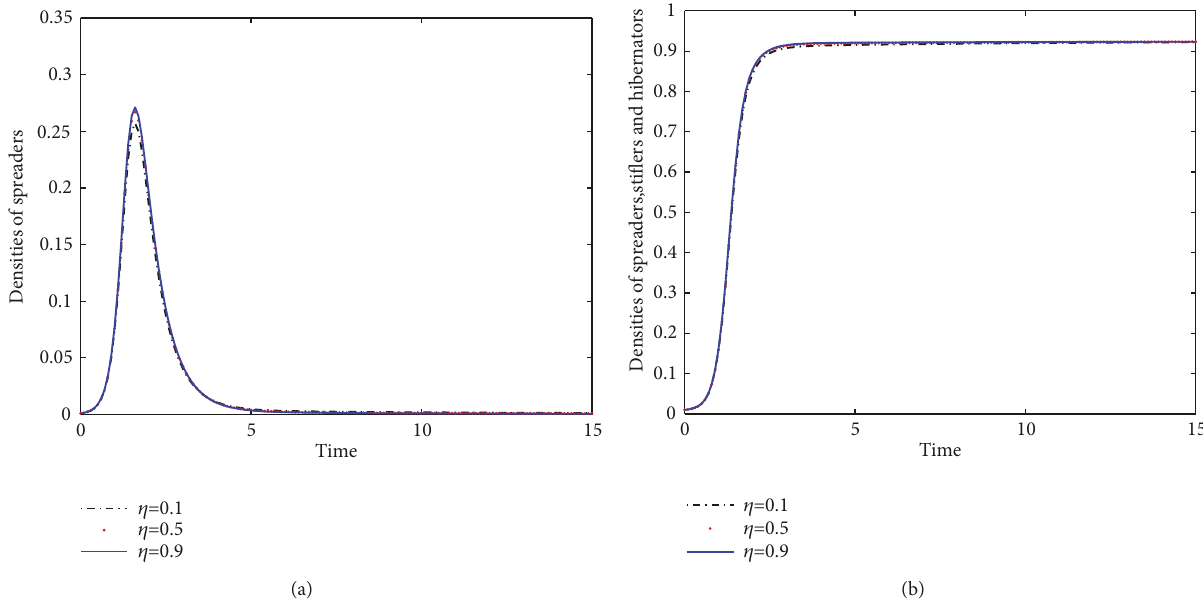
Figure 11: Numerical simulations of (3) with 𝜆 = 0.7 , 𝛽 = 0.3 , 𝛼 = 0.2 , 𝜉 = 0.1 , and 𝛿 = 0.2 and different 𝜂 in the network with the Poisson degree distribution. (a) The trajectories of the densities of spreaders. (b) The trajectories of the densities of spreaders, stiflers, and hibernators.